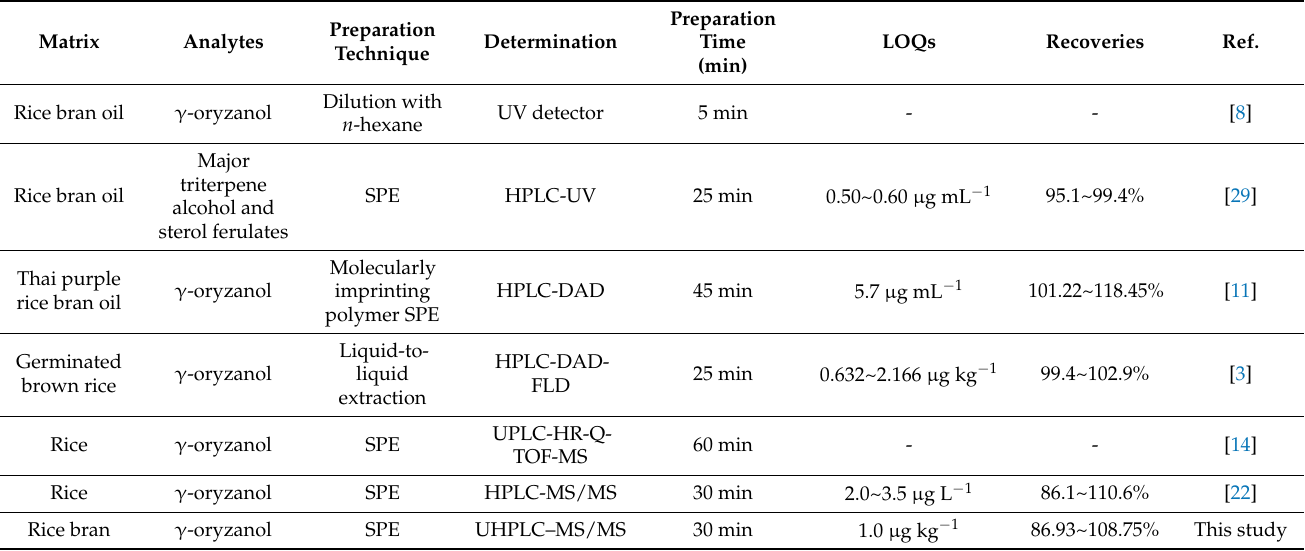
Table 4. Comparison of preparation techniques and LOQs with the reported